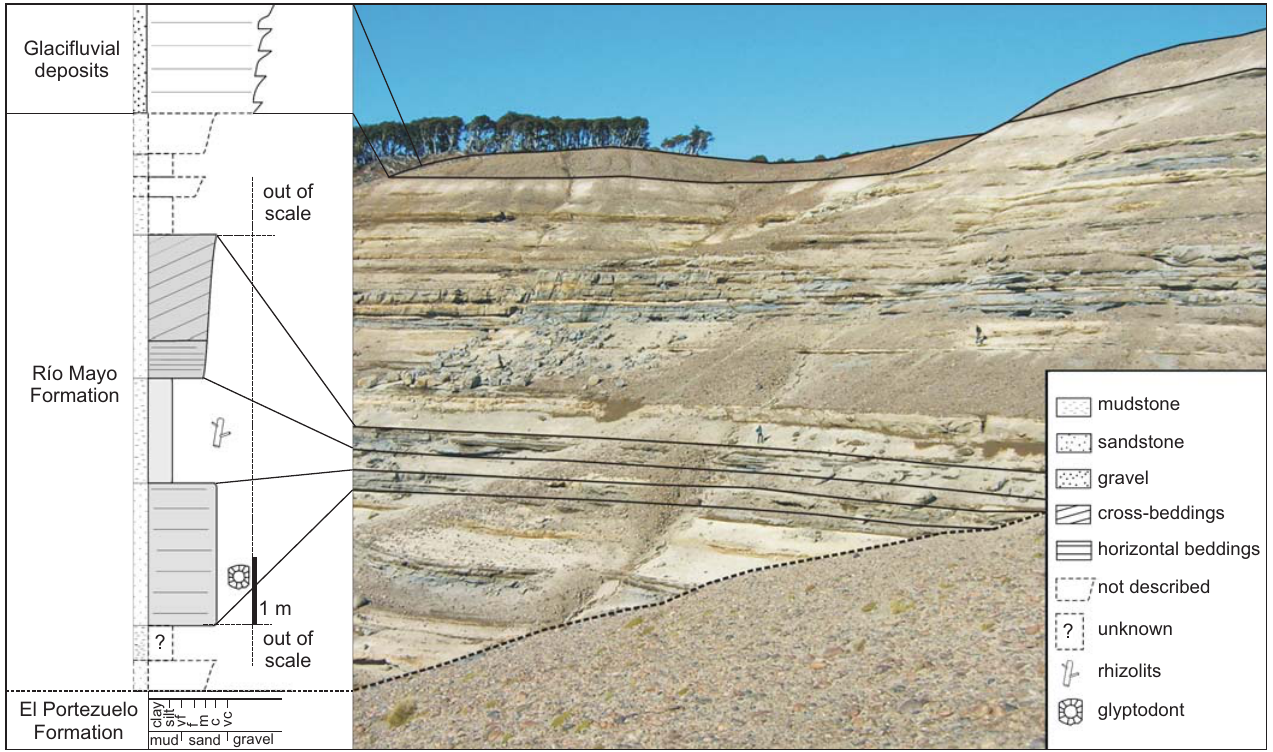
Fig. 2. Stratigraphic profile of the fossil locality (photograph by LRGR, 2015). Abbreviations: c, coarse; f, fine; m, medium; vc, very coarse; vf, very